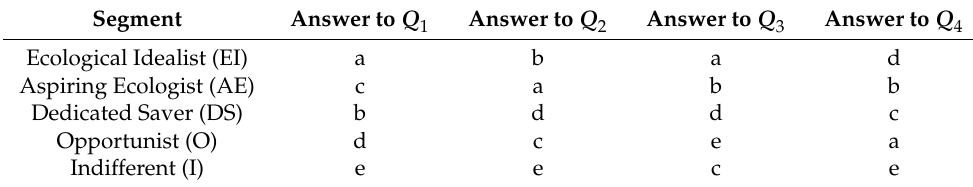
Table 4. Response labelling of the five segments of energy